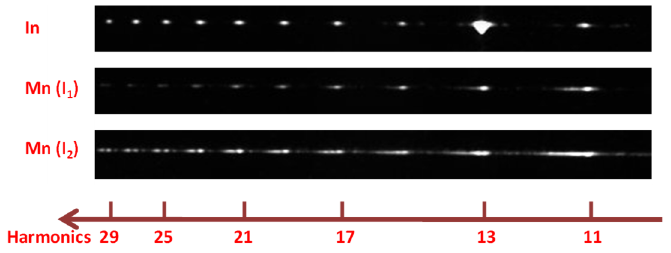
Figure 8. Raw images of harmonic spectra from 800 nm pump (Laser1) in the case of In (upper panel) and Mn (two bottom panels) LIPs. The harmonic spectra in the case of Mn plasma were obtained at two different intensities of PP ( I 1 = 3 × 10 14 W cm −2 and I 2 = 6 × 10 14 W cm −2 ).